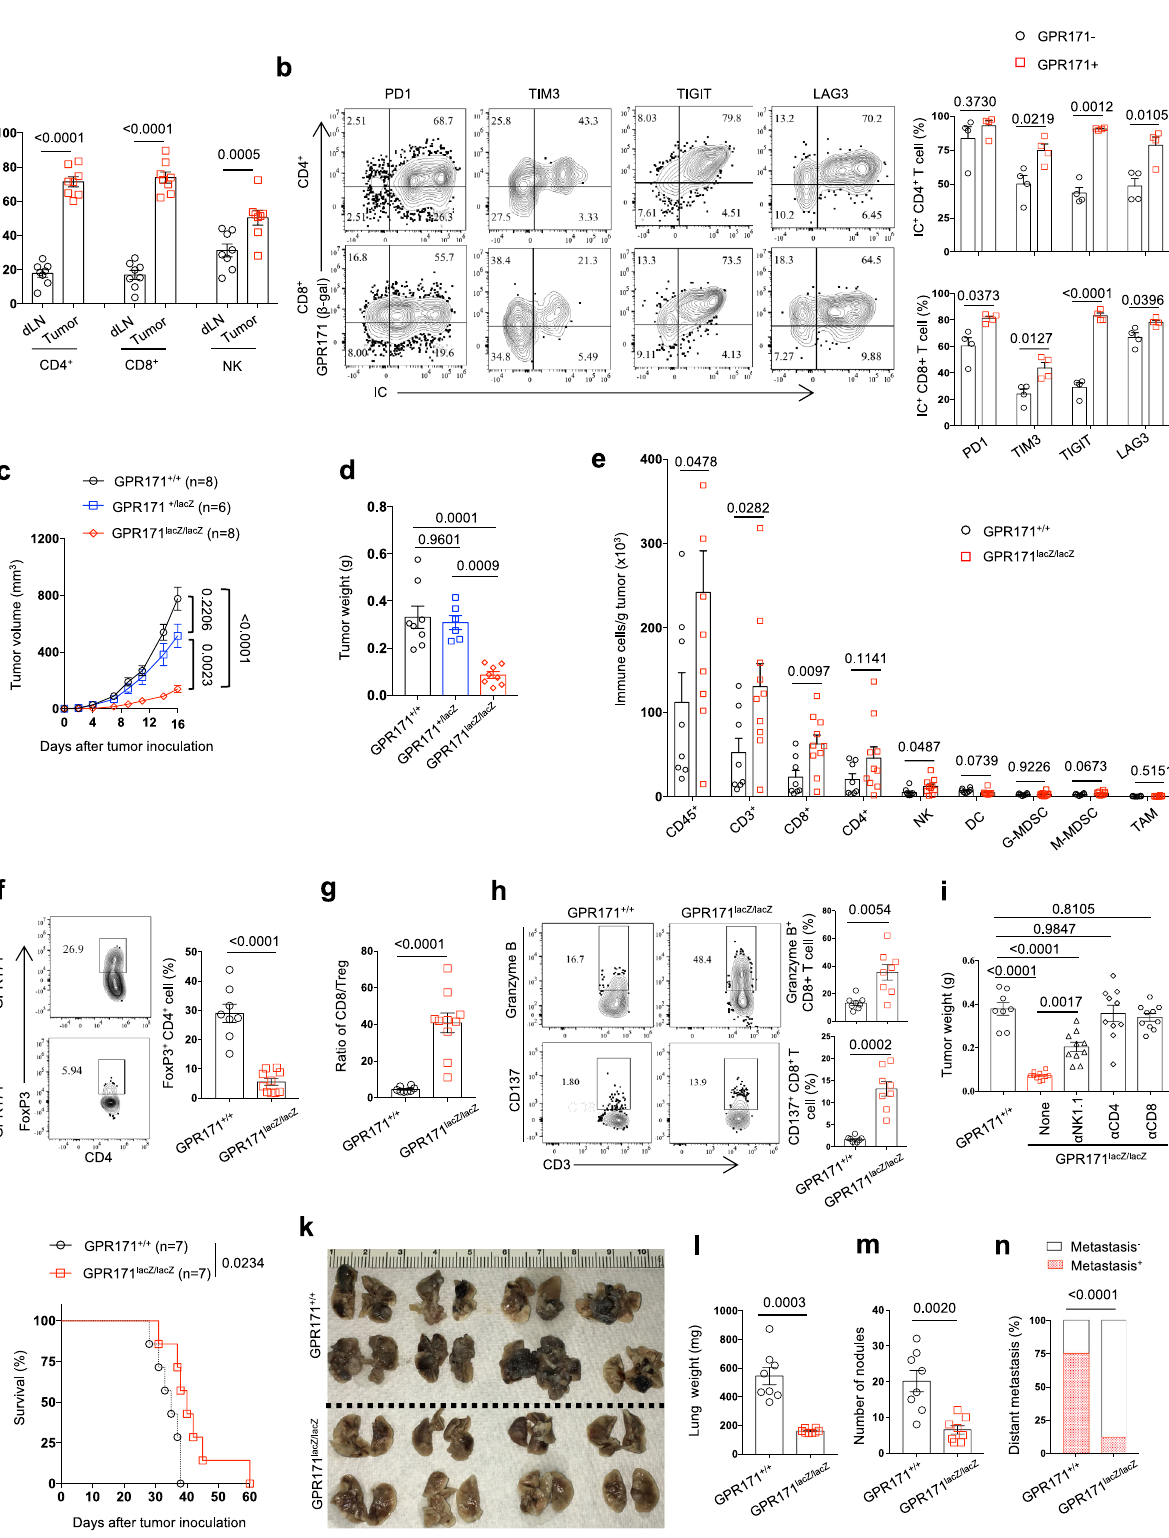
antagonist together with ICB signi fi cantly slowed down B16F1 tumor growth and extended mouse survival (Fig. 6d). When we dissected tumor tissues to examine TILs 14 days after therapy, intratumoral CD8 + T cells were proportionally increased only in the combination group (Fig. 6e); B16F10 tumors under